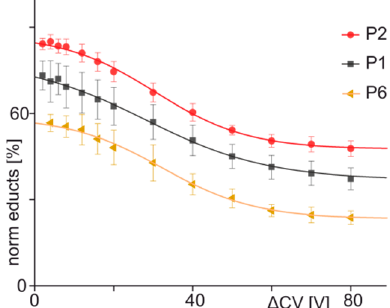
Figure 2. Courses of normalized educt ion intensities of immune complexes of anti-hcTn I antibody and peptides 1 (black squares), 2 (red circles), and 6 (orange triangles) are shown as functions of collision cell voltage differences ( ∆ CV). Each data point is the mean of at least two independent measurements (see Table S1). Vertical bars indicate standard deviations. The sigmoidal-shaped curves were fitted using a Boltzmann function. The curve parameters are given in Table 2.